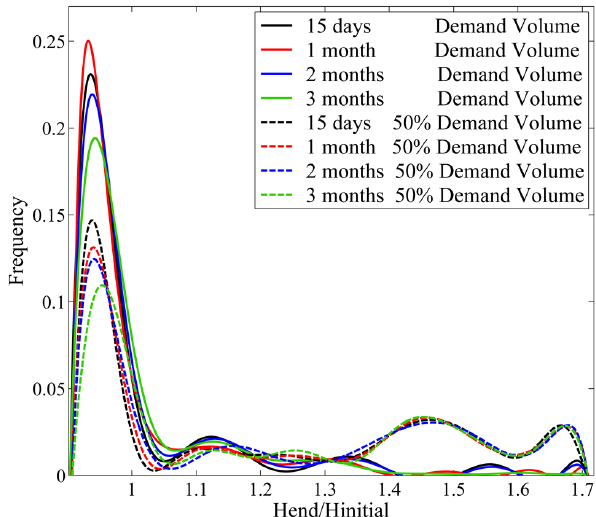
Fig. 5a. Function of probability of the final state of the reservoir compared to its initial state in a ten-year simulation.